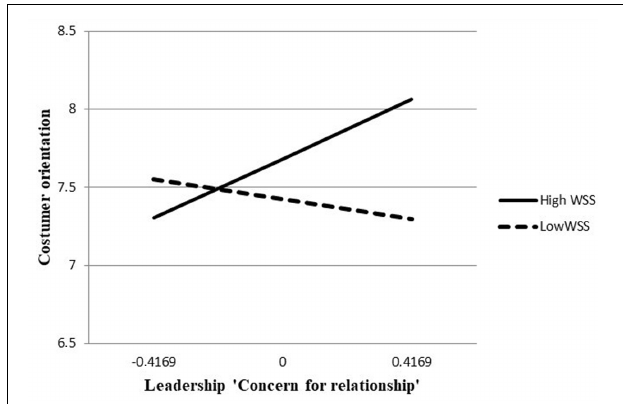
FIGURE 1 | Moderation